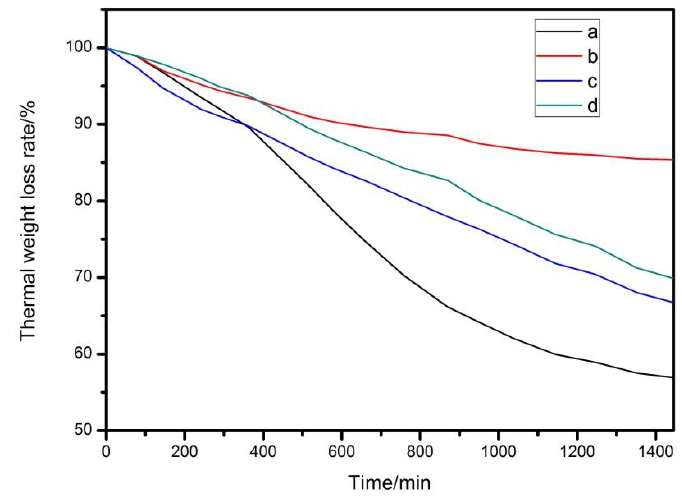
Figure 8. Thermal weight loss rate of ( a ) pure PVC and composites of ( b ) PVC + LDHs, ( c ) PVC + ZnSt 2 and ( d ) PVC + LDHs + ZnSt 2 .